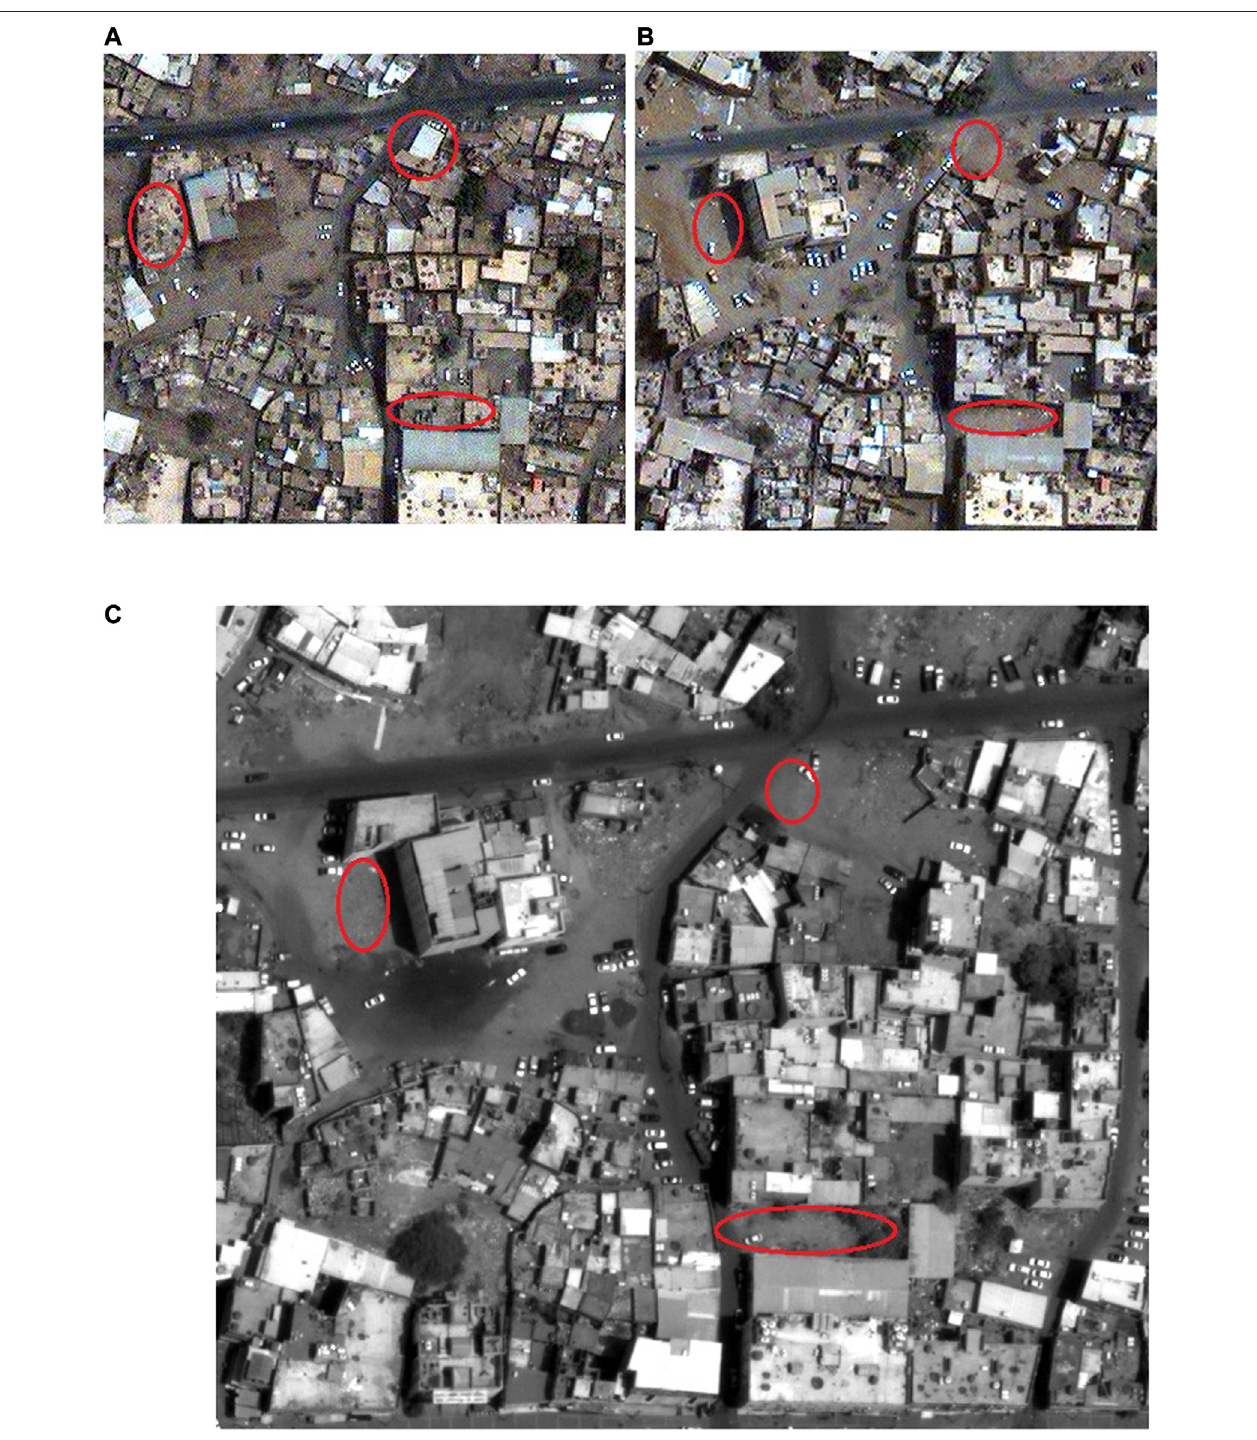
FIGURE 7 | Pan-sharpened natural color QuickBird-2 ( A (cid:1) pre-event and B (cid:1) post-event), and grayscale GeoEye-1 (C) (post-event) images of Shamiya neighborhood.